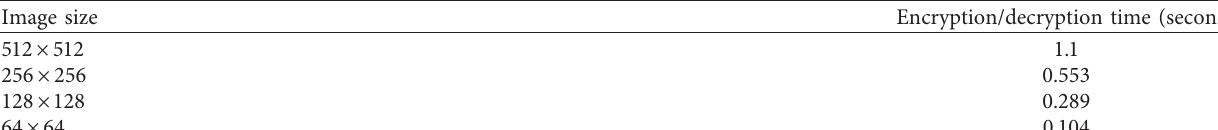
Table 2: Encryption/decryption